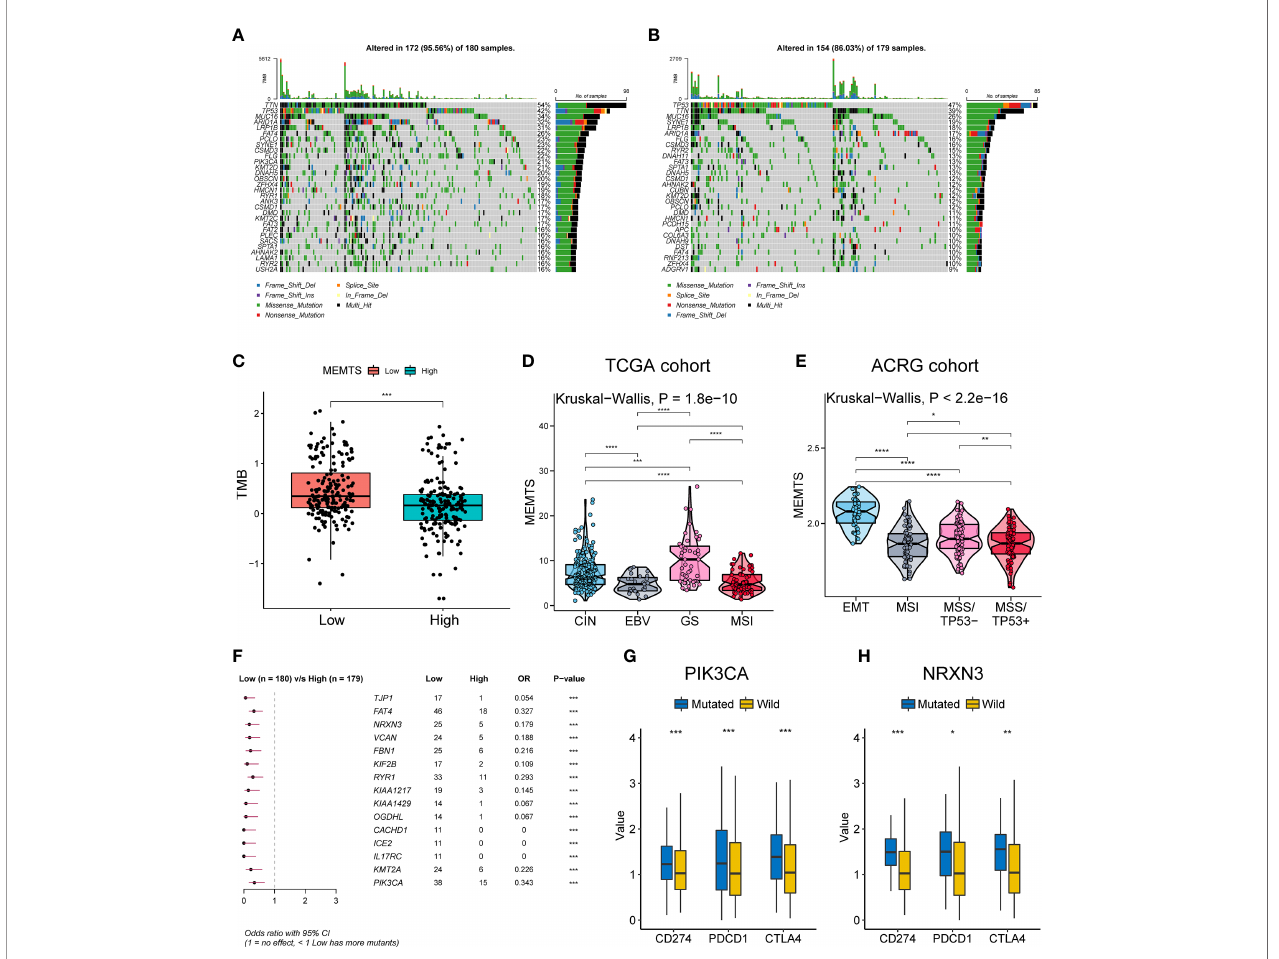
FIGURE 2 | Relationship among the MEMTS, genomic alterations, and molecular subtypes in gastric cancer. (A, B) Oncoplots showing landscapes of genomic alterations in low and high MEMTS subtypes, respectively. (C) Differences in tumor mutation burden between low and high MEMTS subtypes (***P < 0.001, Wilcoxon test). (D, E) The correlations between the MEMTS and TCGA molecular subtypes (Kruskal-Wallis, P = 1.8 × 10 -10 ), as well as ACRG molecular subtypes of gastric cancer (Kruskal-Wallis, P < 2.2 × 10 -16 ). The plot shows the median value, the 25 th , and 75th percentiles (central lines, bottom, and top of the box), while the whiskers embody 1.5 times the interquartile range (*P < 0.05; **P < 0.01; ***P < 0.001, ****P < 0.0001, Wilcoxon test). (F) Top 15 genes with the highest mutation frequency related to the MEMTS in the TCGA cohort. (G, H) PIK3CA and NRXN3 mutations distinctly facilitated expression of